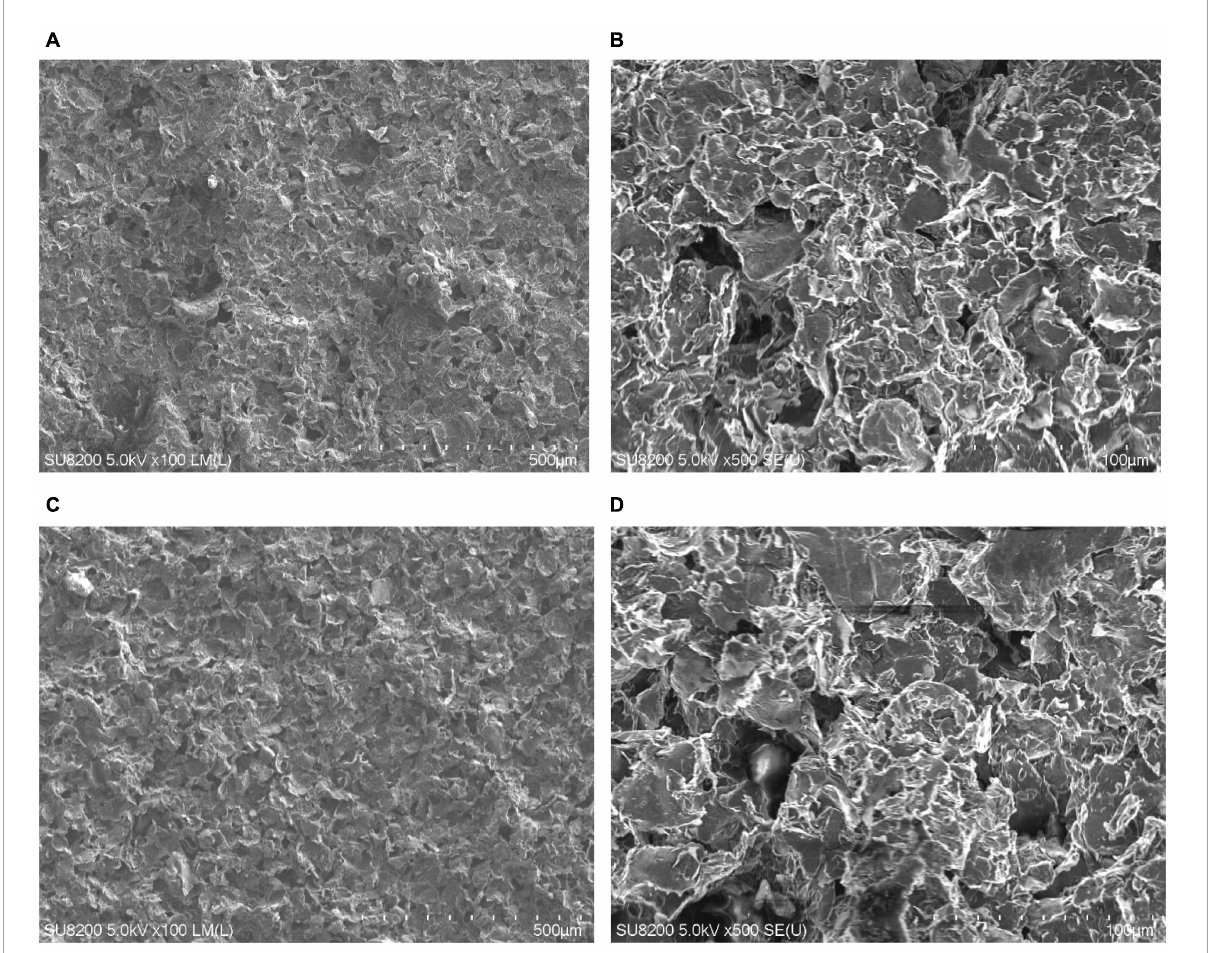
FIGURE3 Scanning electron microscope images showing microgeometry of coatings. (A,B) Microgeometry of substrates made with inks sonicated using sonotrode for 1 min, (C,D) with inks prepared using the ultrasonic bath for 30 min. (A) One minute – sonotrode, × 100 magnification; (B) 1 min –